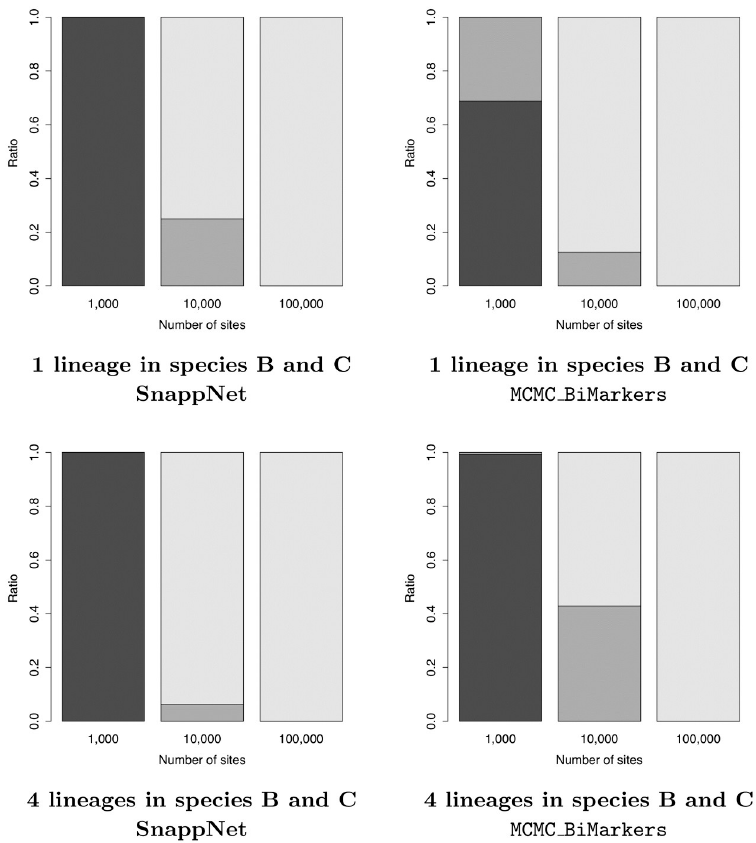
Fig 14. Frequency of trees (black), 1-reticulation networks (dark grey), 2-reticulations networks (light gray) sampled by S NAPP N ET and MCMC_BiMarkers , when data were simulated from Network C (see Tables 2 and 3). Recall that network C contains 2